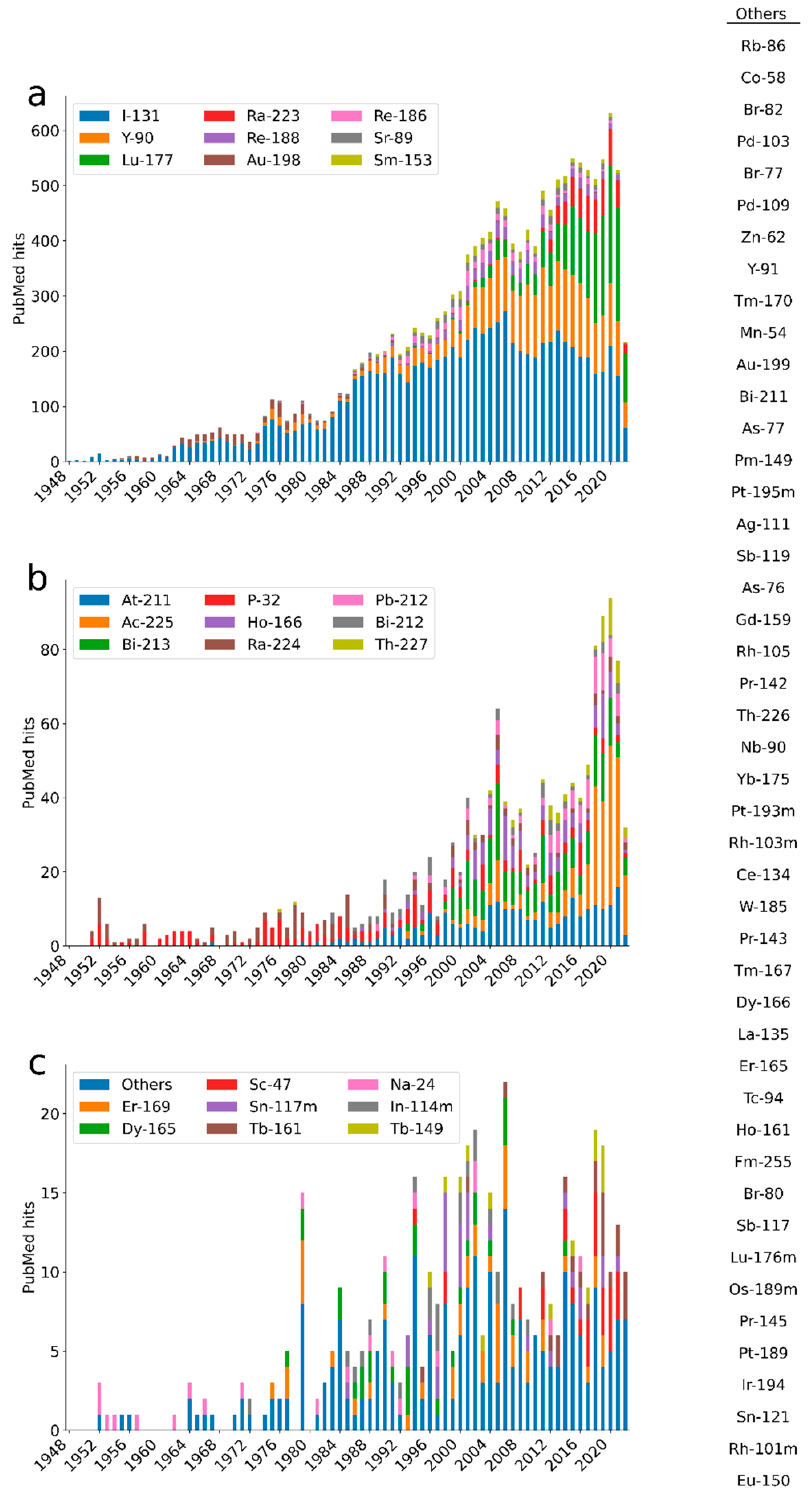
Figure 1. The number of hits in PubMed as of 30 June 2022, per radionuclide and year of publication. The radionuclides have been separated according to the aggregated numbers of publications across panels ( a – c ). The radionuclides with fewer than 13 hits total have been aggregated into “Others” and are listed to the right in the figure. The search strategy and search strings are described in Supplementary File